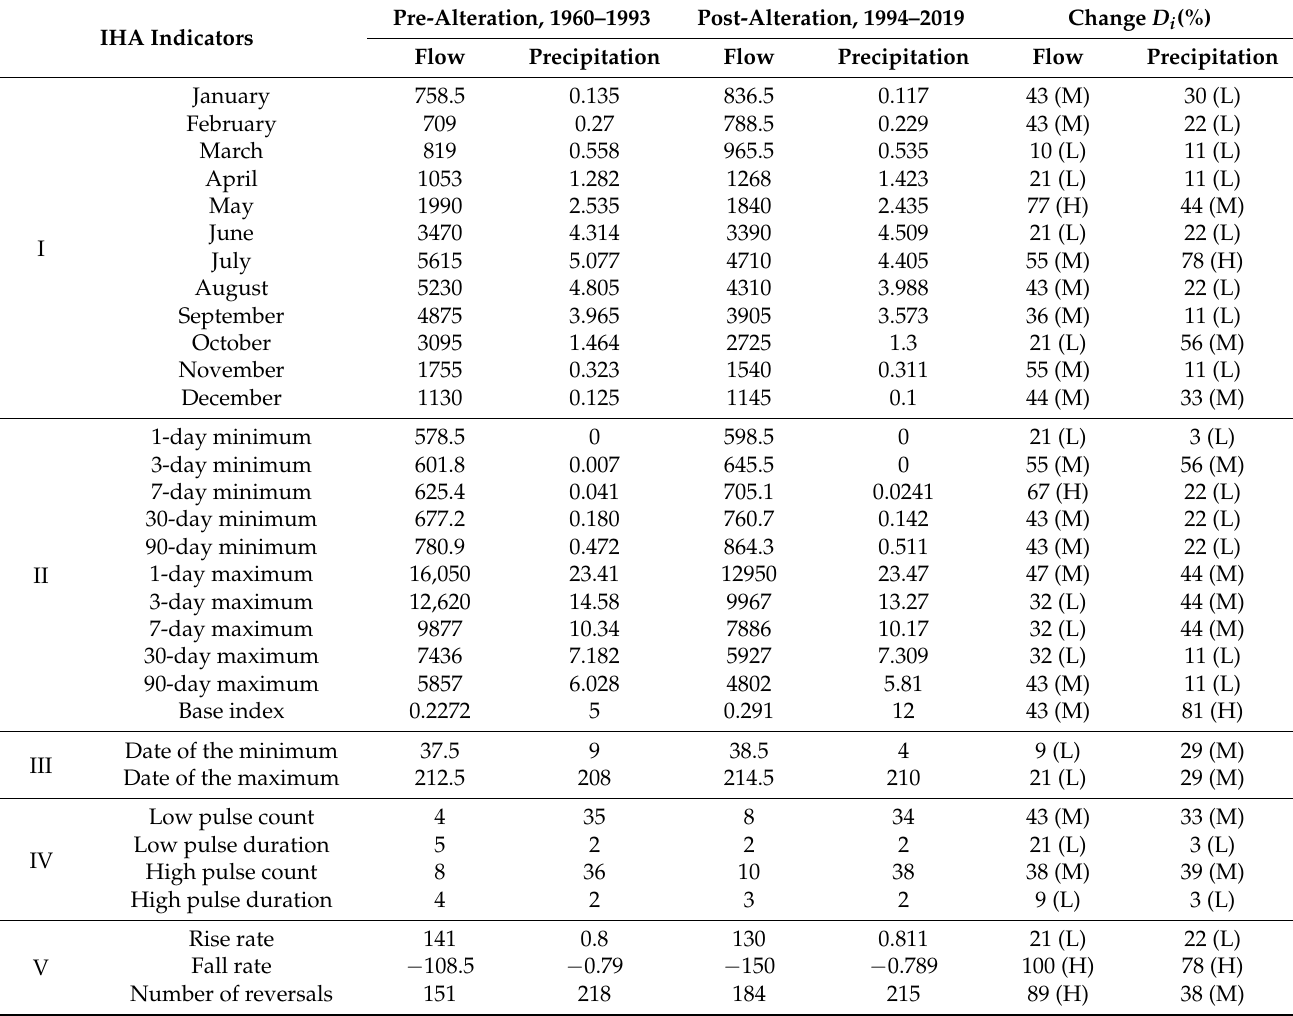
Table 3. Statistical table of IHA indicators before and after the alteration of the Min